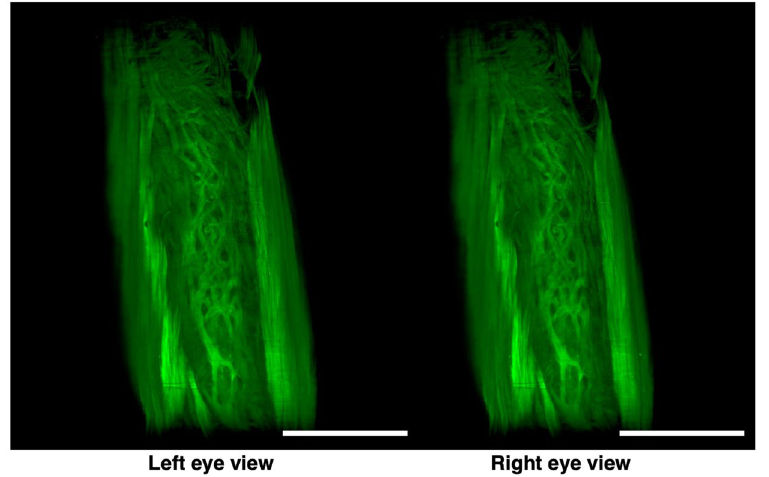
Figure 3. Stereoscopic image of the mesh-like muscle structure in the uterus of EGFP transgenic mice. Female CAG-EGFP transgenic mice were transcardially perfused with 4% PFA containing PI. After the isolated uterus was subjected to CUBIC, 3D images were taken by light-sheet microscopy, and then stereoscopic images were reconstructed. When producing a combined stereoscopic image from right-and-left 2D figures, we can clearly recognize an intricate whole picture of these mesh-like structures. Scale bars, 1